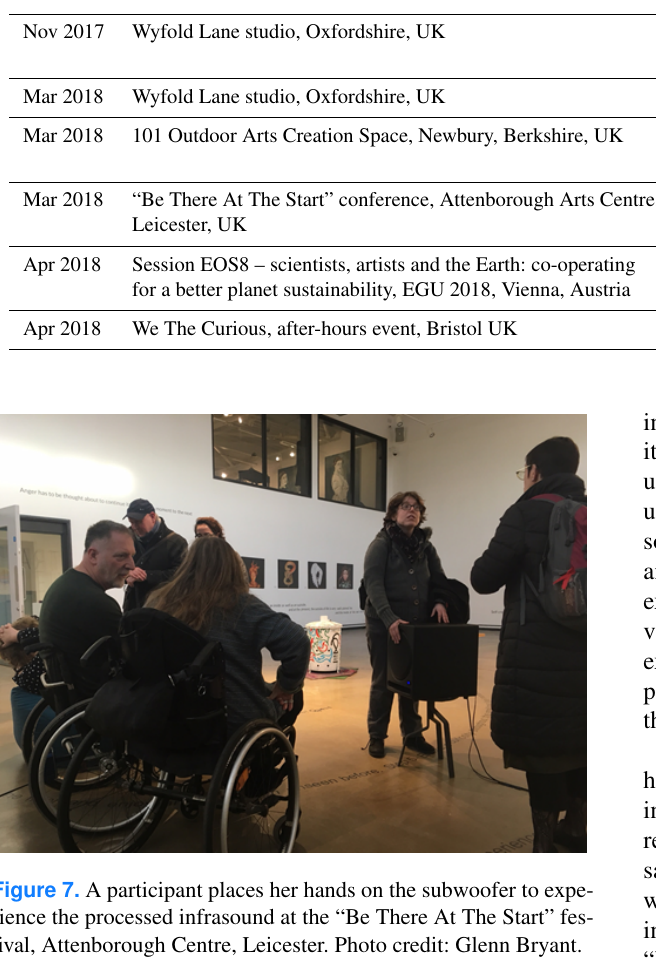
able and not enjoyable. Responses were sought from those experiencing the artwork, which included the